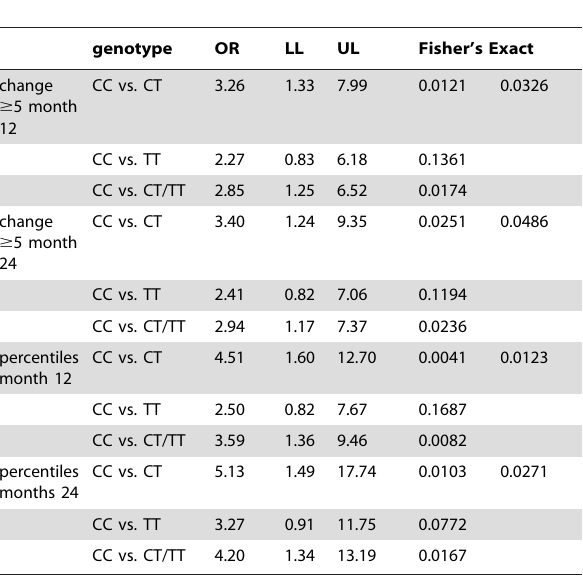
Table 2. Effects of genotype SNP rs1061170 at CFH